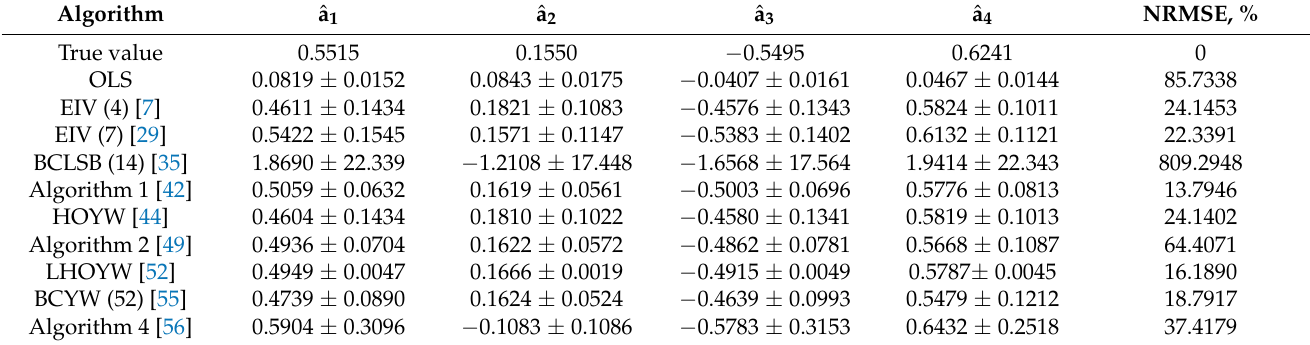
Table 7. The mean values of the parameter estimates and their standard deviations (SNR = − 5